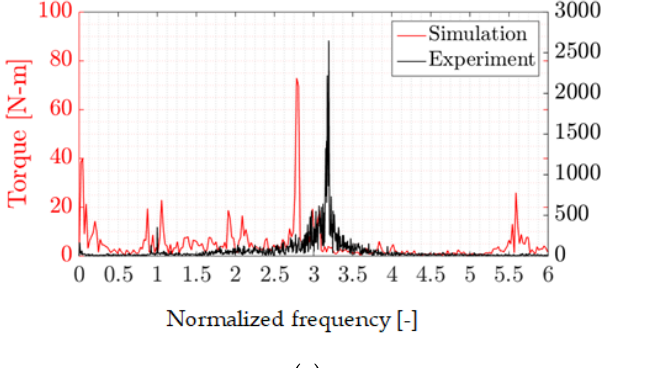
Figure 9. Numerical absolute pressure contours in the runner domain.